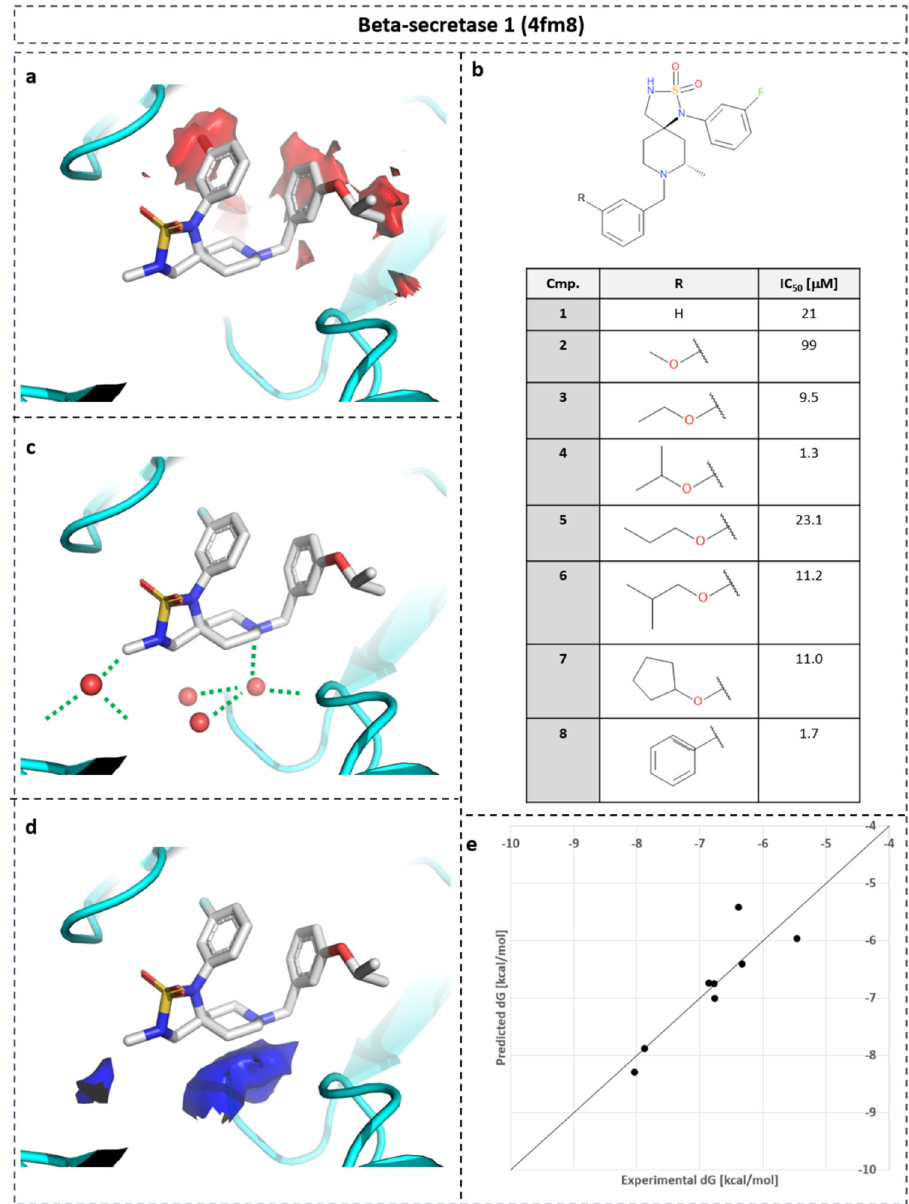
Fig. 12 SAR of BACE-1 inhibitors. SAR of BACE-1 inhibitors guided by gain in desolvation free energy based on point-wise neural-network model. a Co- crystalized compound 4 in PDB structure with ID 4fm8. b SAR table of eight inhibitors with substituents replacing water density with unfavorable free energy ( a : isolevel: 7.5 kcal mol − 1 ). c Water-mediated protein – ligand interactions overlap with water density with favorable enthalpy ( d : isolevel: − 3 kcal mol − 1 ). e Linear regression between predicted desolvation and experimental binding free energy for SAR series ( r 2 =